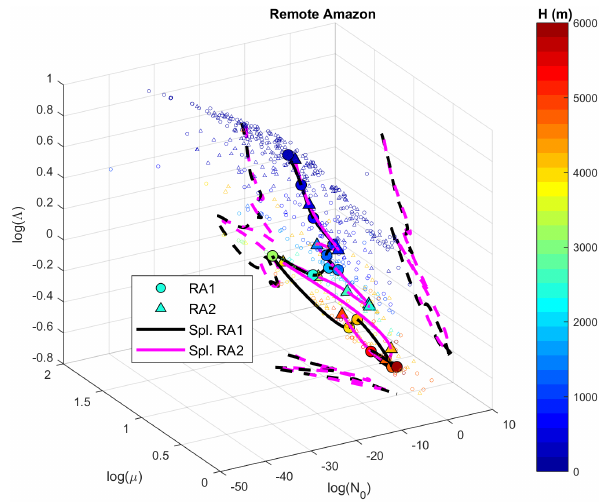
Figure 6. Similar to Fig. 5, but for flights RA1 and RA2 over the remote